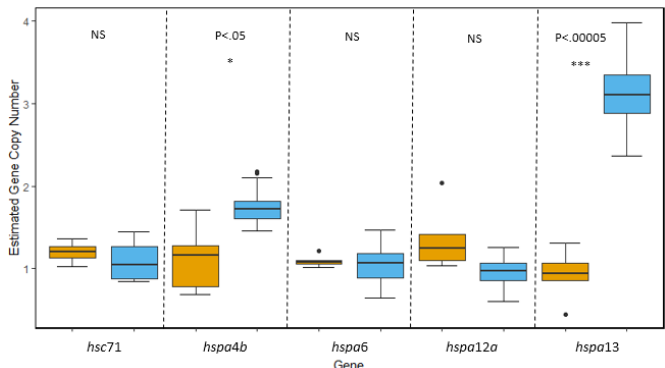
Figure 3. Comparisons of gene copy number of five isoforms within the hsp70 superfamily in T. bernacchii (blue) and N. angustata (orange). For the major ancestrally constitutive isoform hsc71, a non-significant difference in average gene copy number was determined to be 1.1 copies in T. bernacchii and 1.2 copies in N. angustata . Isoforms hspa 4 b and hspa 13 in T. bernacchii displayed evidence of gene duplication with an average copy number of 1.76 and 3.1 copies, respectively. Significant differences in gene copy number were observed with N. angustata having an average of 1.12 copies of hspa 4 b per genome ( p < 0.05) and 0.92 copies of hspa 13 per genome ( p < 0.00005). No significant difference in gene copy number was observed for ancestrally inducible isoforms hspa 6 and hspa 12 a with T. bernacchii carrying an average of 1.04 and 0.97 copies per genome respectively, and N. angustata carrying an average of 1.09 and 1.36 copies per genome, respectively. Box and whiskers represent quartile ranges with circles representing outliers.